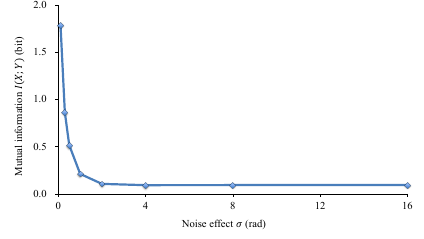
Figure 3: Impact of noise on mutual